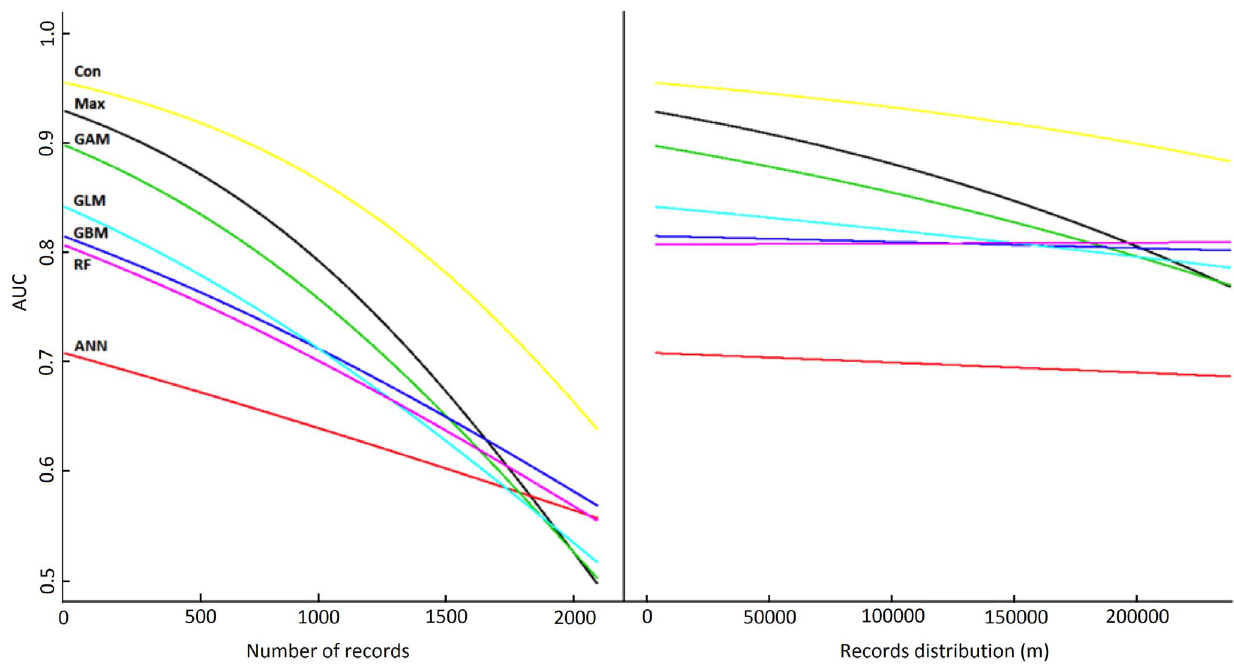
Figure 1. Effect of records’ availability and spatial distribution on model fit. Effect of records availability and spatial distribution on model fit based on the AUC evaluation of the different algorithms. For the AUC evaluation, we present the back-transformed mean values estimated using Linear Mixed Effect models for each algorithm. The first column presents the results with relation to the number of records and the second with relation to the records distribution.